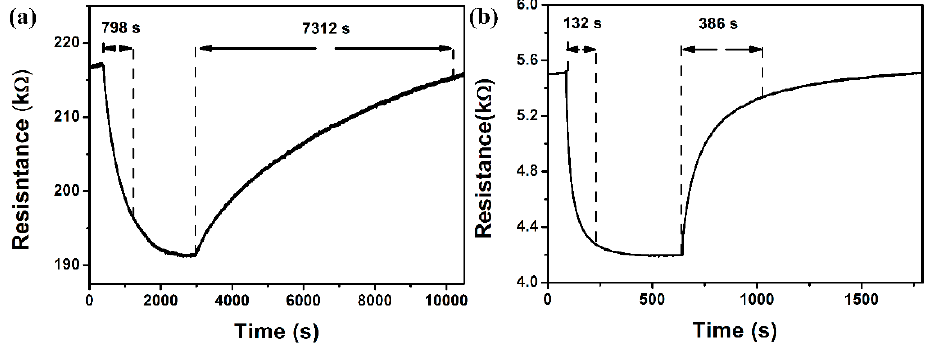
Figure 6. The response curve to 5 ppm NO 2 of the sensors based on ( a ) rGO; ( b ) rGO/Au at 50 °C.